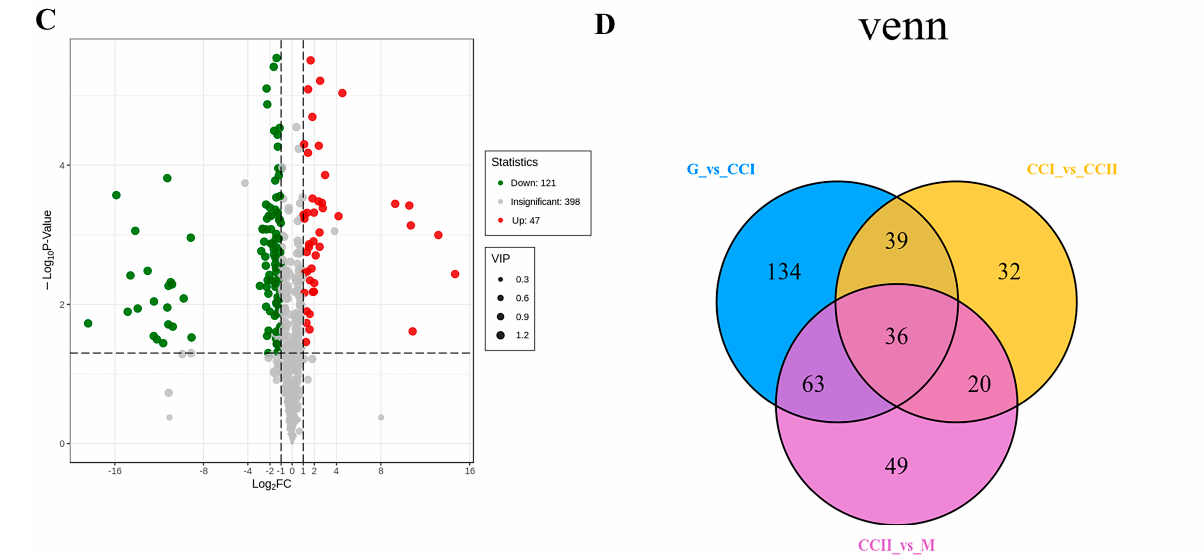
Figure 2. ( A )–( C ): Volcano plots of the different metabolites in the three comparison groups (G vs. CC I, CC I vs. CC II and CC II vs. M). ( D ): Venn diagram of differential metabolites among G vs. CC I, CC I vs. CC II and CC II vs. M.